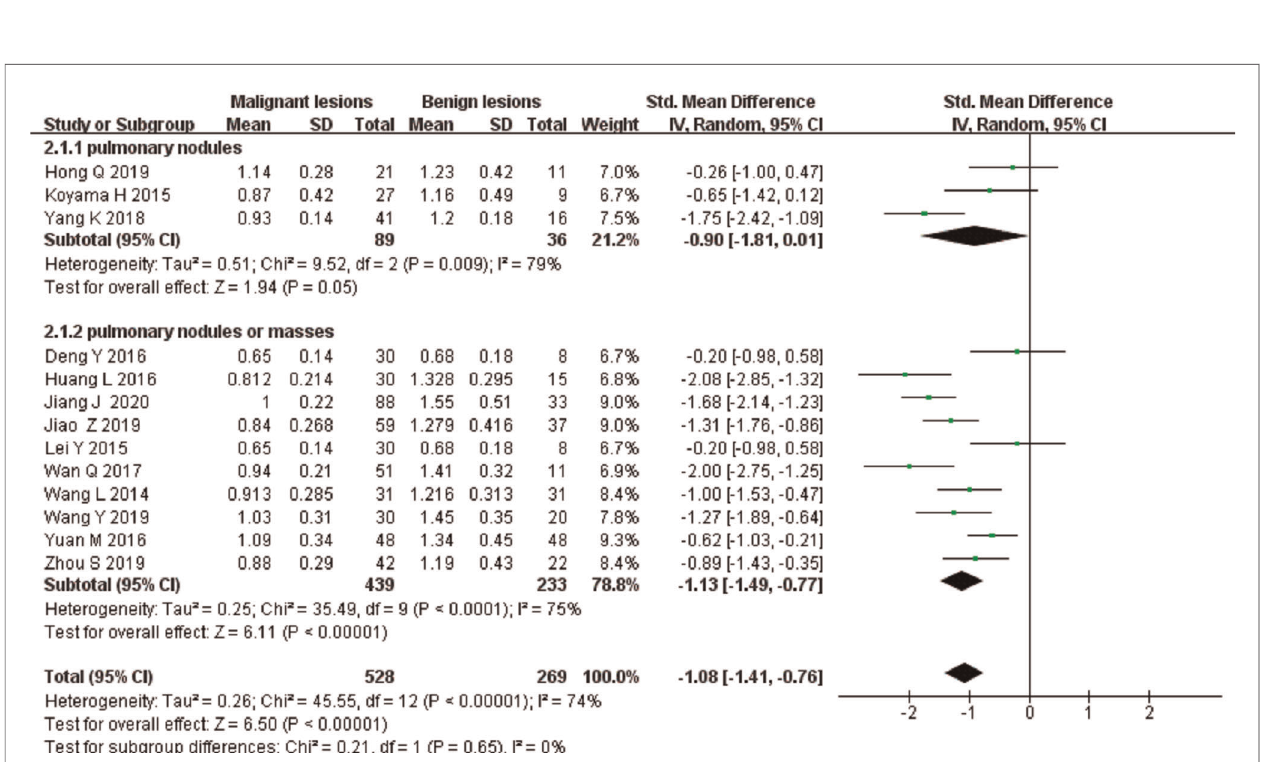
FIGURE 5 | Forest plot of the mean value of the tissue diffusivity ( D value) between malignant and benign pulmonary nodules and